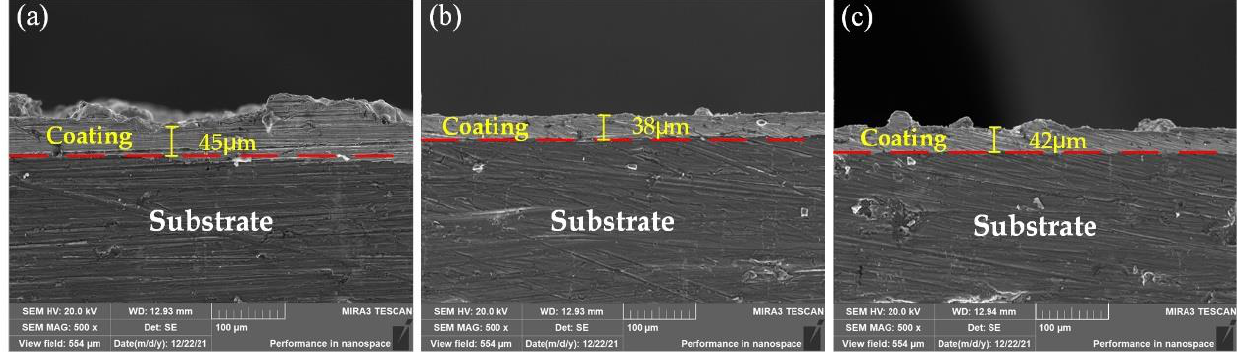
Figure 4. SEM images for the cross-section. ( a ) S2 sample; ( b ) S3 sample; ( c ) S4 sample.